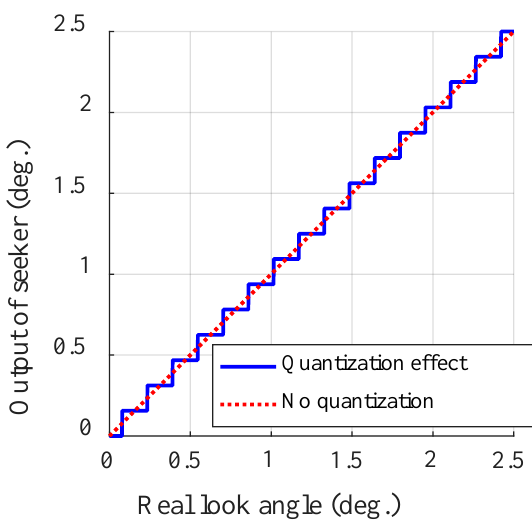
Figure 3. Quantization effect of a